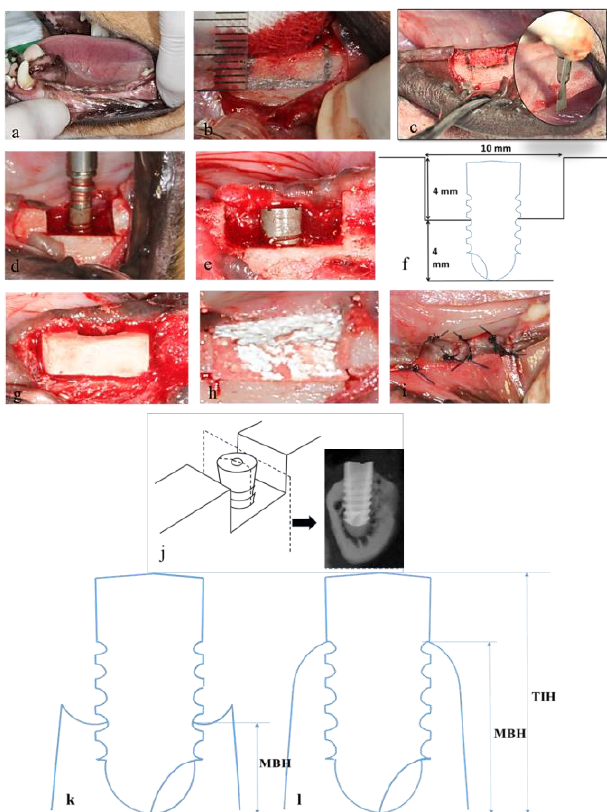
Figure 2. The surgical procedure used for inserting the implant after creating a saddle bone defect and cross-sectional images captured for calculating the final bone coverage. ( a ) Healed edentulous ridge before surgery. ( b , c ) Rectangular saddle defects were meticulously marked and created surgically using a mini-surgical saw (circle in (c)). ( d ) Drilled osteotomies were prepared for implant placement. ( e ) The width and depth of the peri-implant bone defect. ( f ) The clinical preparation of an alveolar defect for graft testing. ( g ) Insertion of DCP/HA biphasic ceramics graft. ( h ) Cover the graft with collagen membrane. ( i ) Wound closure with 4-0 nylon sutures. ( j ) The sectional plane cut through the implant along the coronal plane to create a buccal–lingual sectional plane. ( k , l ) Cross-sectional images for calculating the final bone coverage when the marginal bone was lost ( k ) or gained ( l ) peri-implant.